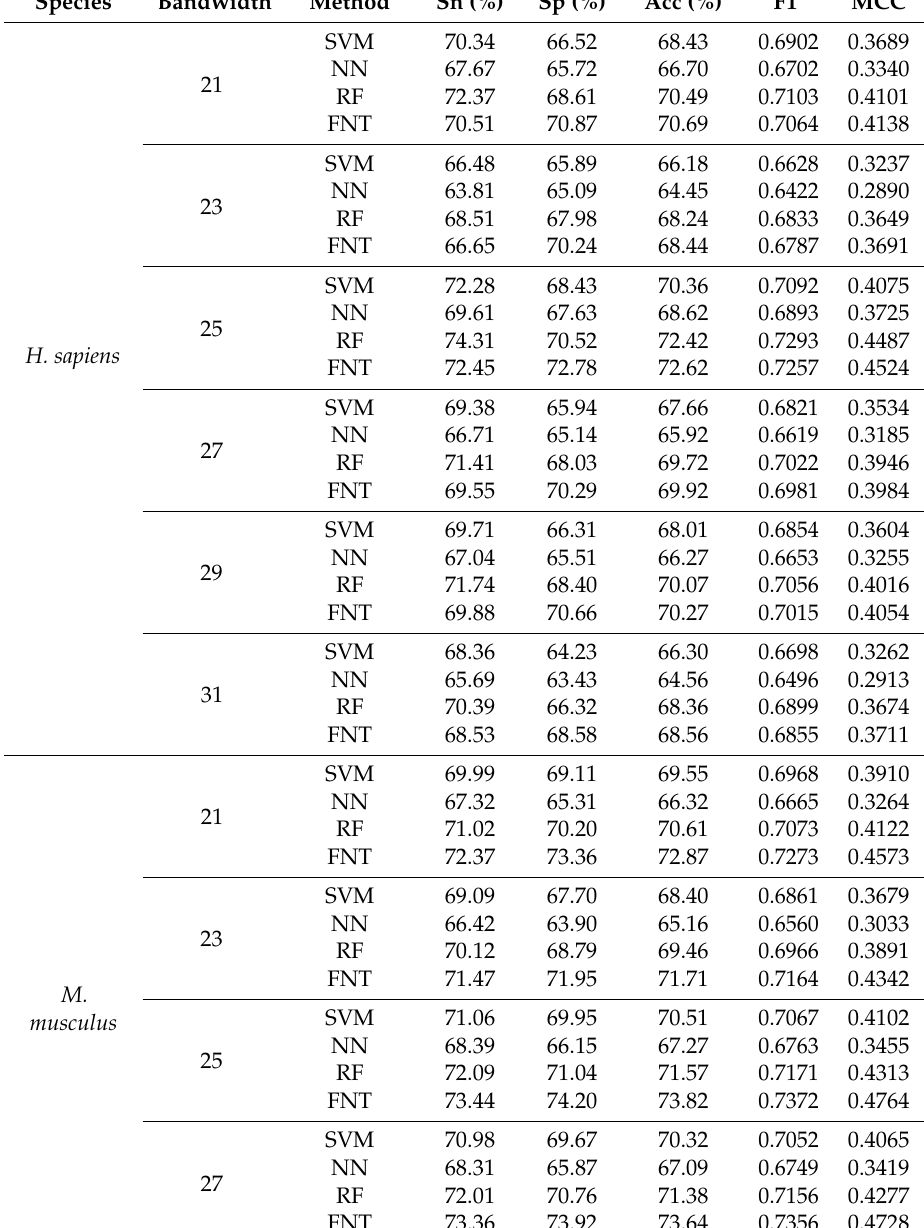
Table 7. Performance using different bandwidths. SVM—support vector machine; NN—neural network; RF—random